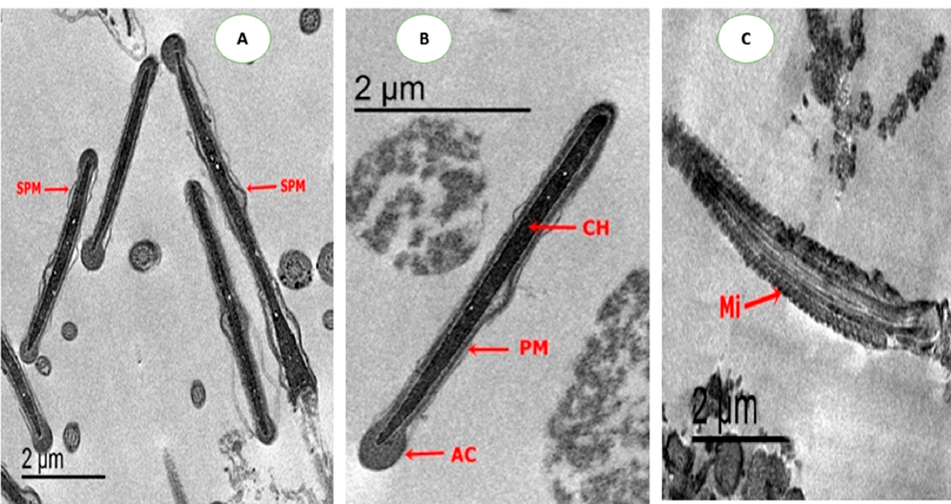
Figure 3. TEM photomicrographs of rabbit sperm head in groups treated with 1.0 µg/mL of CU or CUNPs. ( A ). A longitudinal section of head sperm showing normal nucleus and slightly extension of the cell membrane (SPM); ( B ). Intact plasma membrane (PM), apical ridge formation (AC), a normal nucleus with condensed chromatin (CH); ( C ). A mild degree of mitochondrial sheath damage was observed, and some regions have normal mitochondria.